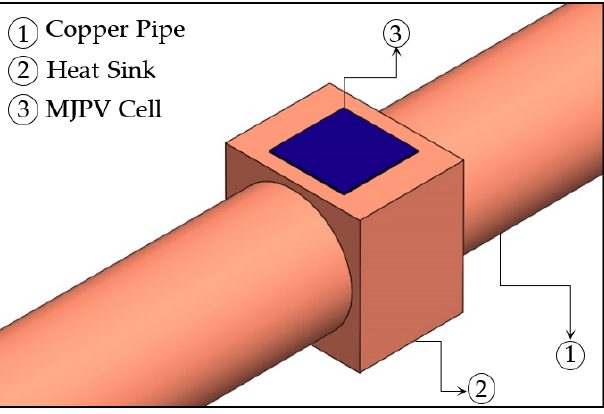
Figure 6. Isometric view of the CPVT model in ANSYS Design Modeler.